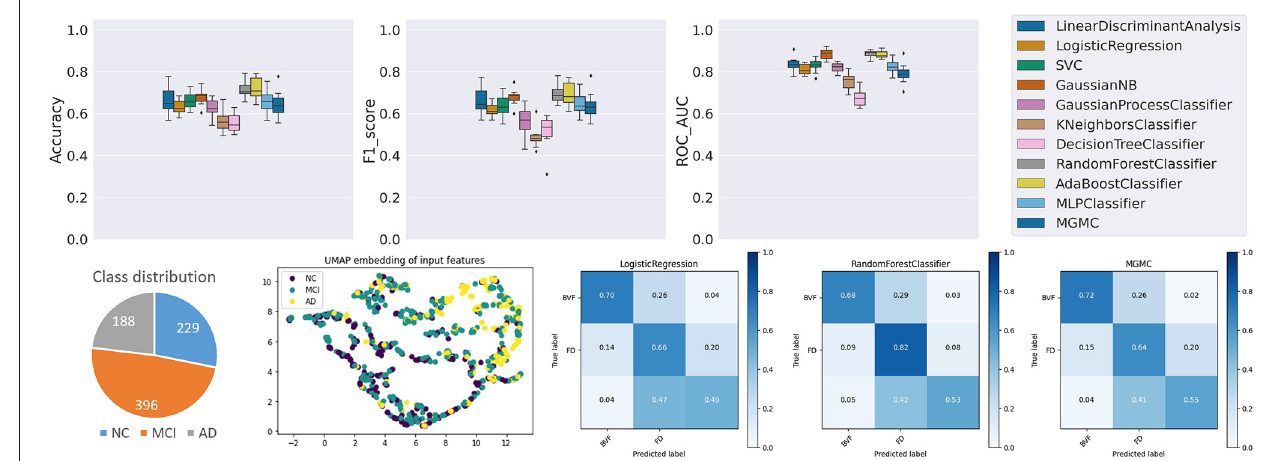
FIGURE A1 | Results panel produced by base-ml for